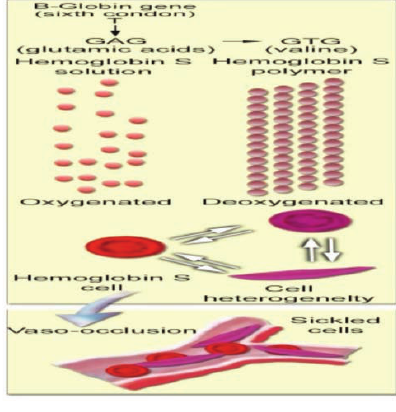
Figure 1. Molecular and cellular changes of hemoglobin S. 12 Legend: β 6Glu ⇒ Val. Deoxy Hb S polymer forms with low O2, Causes irreversibly sickled cells. Under a variety of circumstances, different organs are susceptible: esp. bone, spleen, and lung.